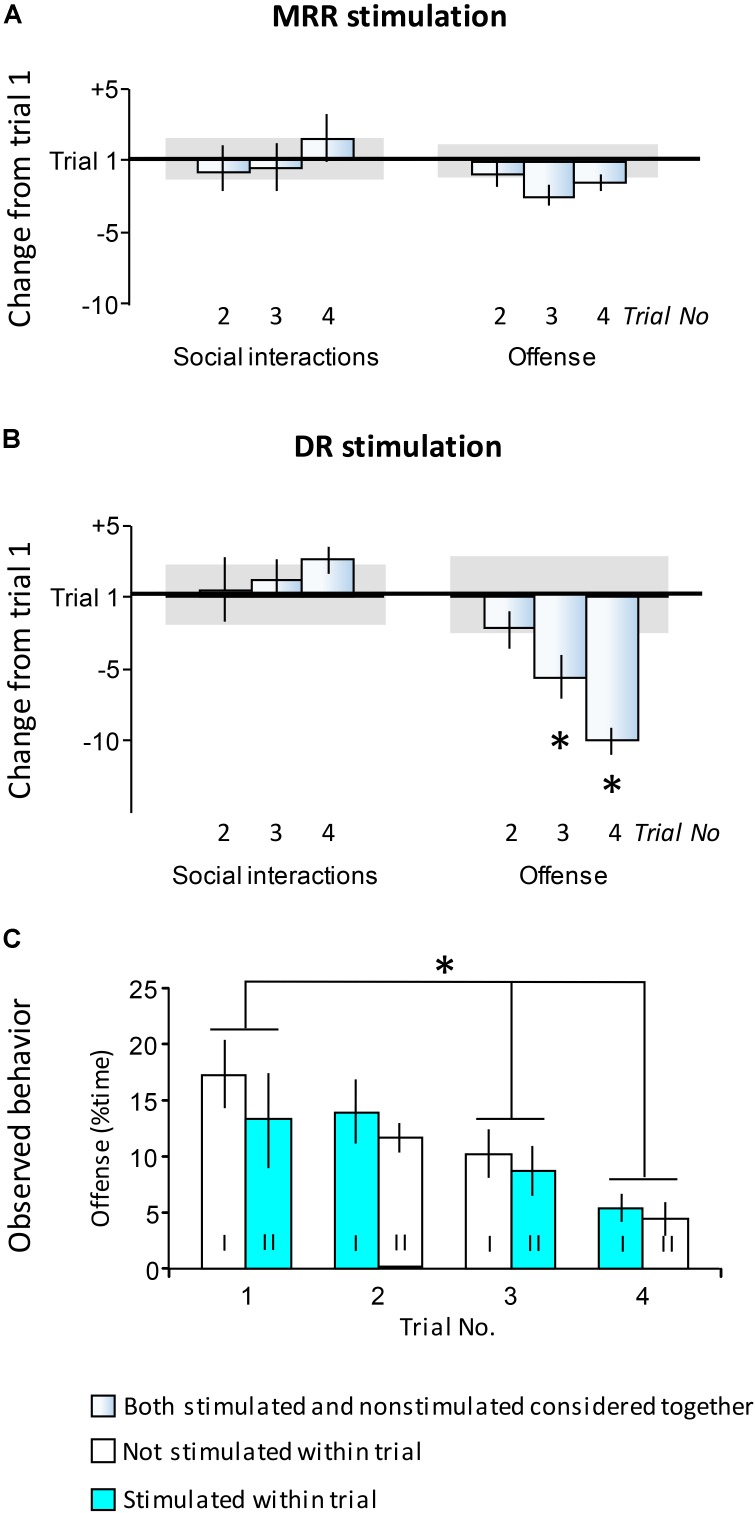
Carryover effects of stimulations. Findings presented here show behavior observed in trials 2, 3, and 4 when all mice had a history of stimulation. The aim of this study was to investigate carryover effects (see Experimental design). (A,B) Differences in the duration of behaviors as compared to trial 1. Values show differences in the time devoted to a particular behavior expressed as the percentage of total test time. (C) The duration of offense in trials 1–4. Here data were shown separately for mice stimulated or non-stimulated within the particular trials. Each cohort of mice (indicated by roman numbers) was submitted to alternating trials of stimulation and non-stimulation. Horizontal line in
(A,B), the average duration of behaviors in trial 1; Horizontal bars in
(A,B) standard errors of the average duration of behaviors in trial 1; DR, dorsal raphe; MRR, median raphe region; ∗Significant differences between trials in post hoc tests (p < 0.05 at least).